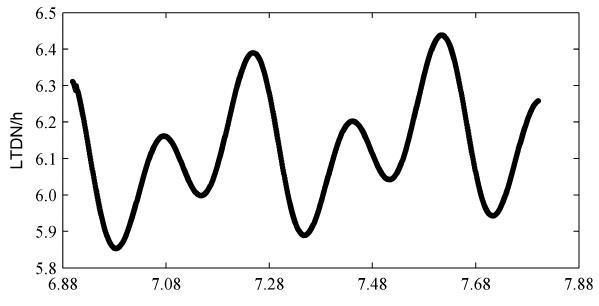
Figure 1. LTDN variations